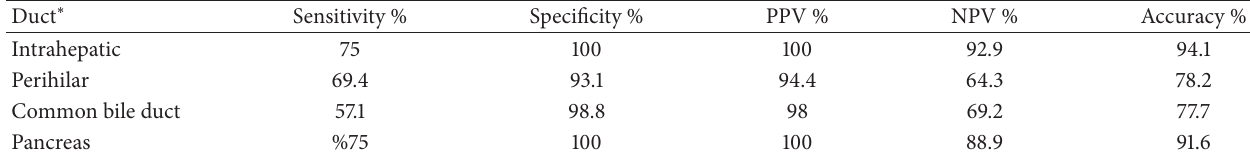
Table 3: The diagnostic success of brush cytology according to stricture location.